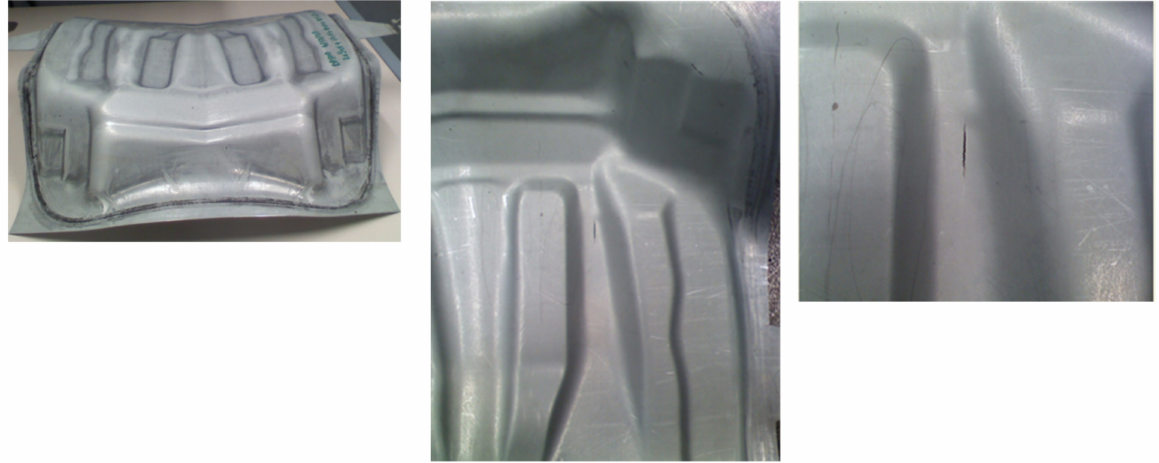
Figure 11. EHF formed part with splits in the areas of maximum